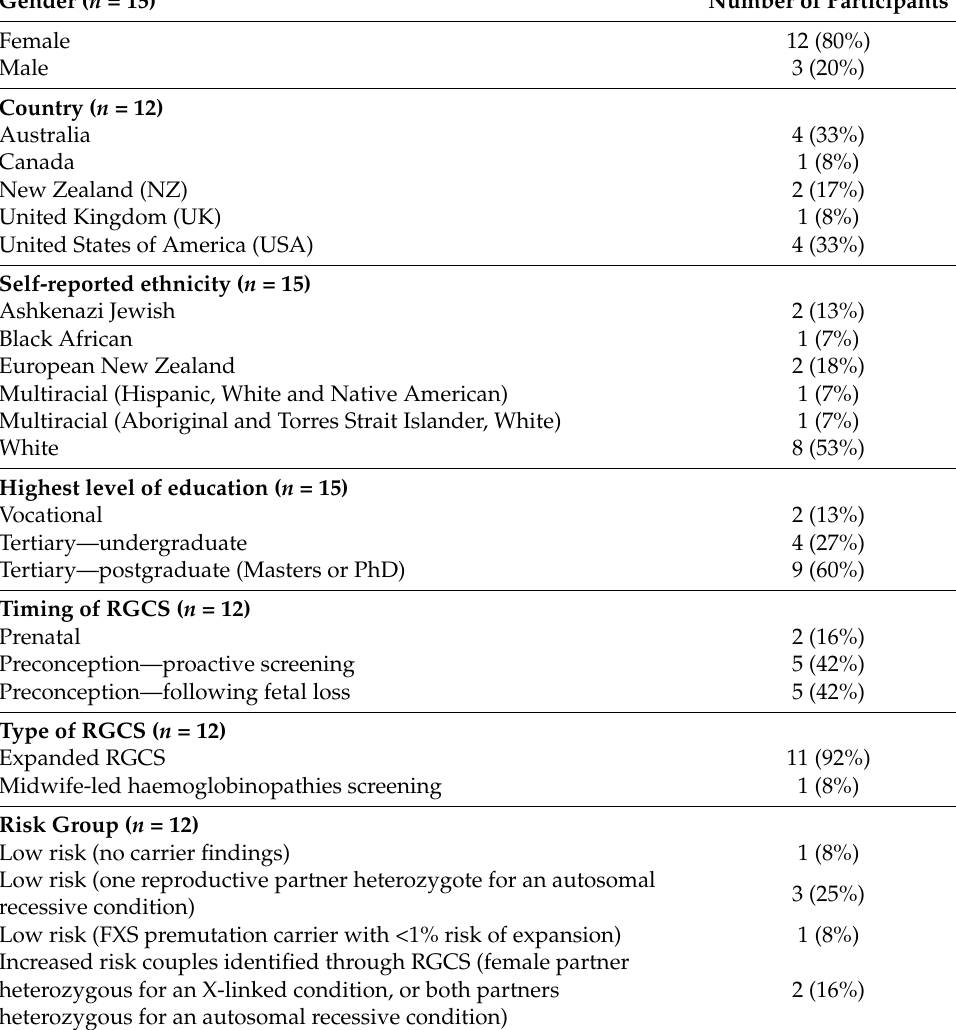
Table 1. Summary of